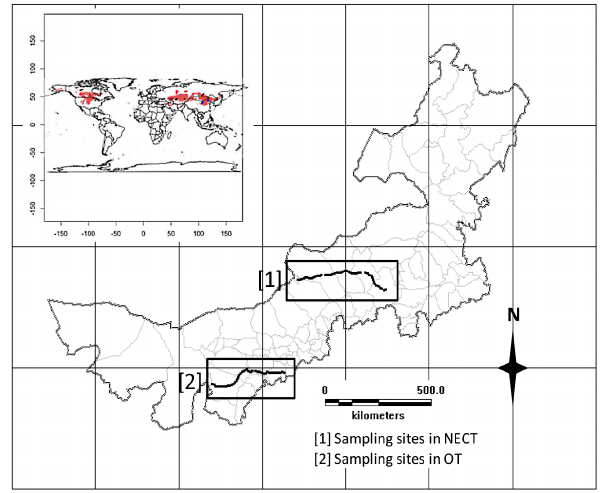
Figure 2. The sampling sites in Inner Mongolia, China. The 46 northern sites (1) were along the North-East China Transect (NECT), and the 41 southern sites (2) were along the Ordos Tran- sect (OT). The map in the upper left corner shows places in the world with a similar climatic regime to the study area – with similar annual and seasonal pattern of precipitation and temperature; that is, with mean annual precipitation ranging from 160 to 440mm, and most of MAP occurring from May through September, and with mean annual temperature from 1 to 9 ◦ , mean temperature of the coldest month from − 20 to − 10 ◦ (January), and mean temperature of the warmest month from 19 to 24 ◦